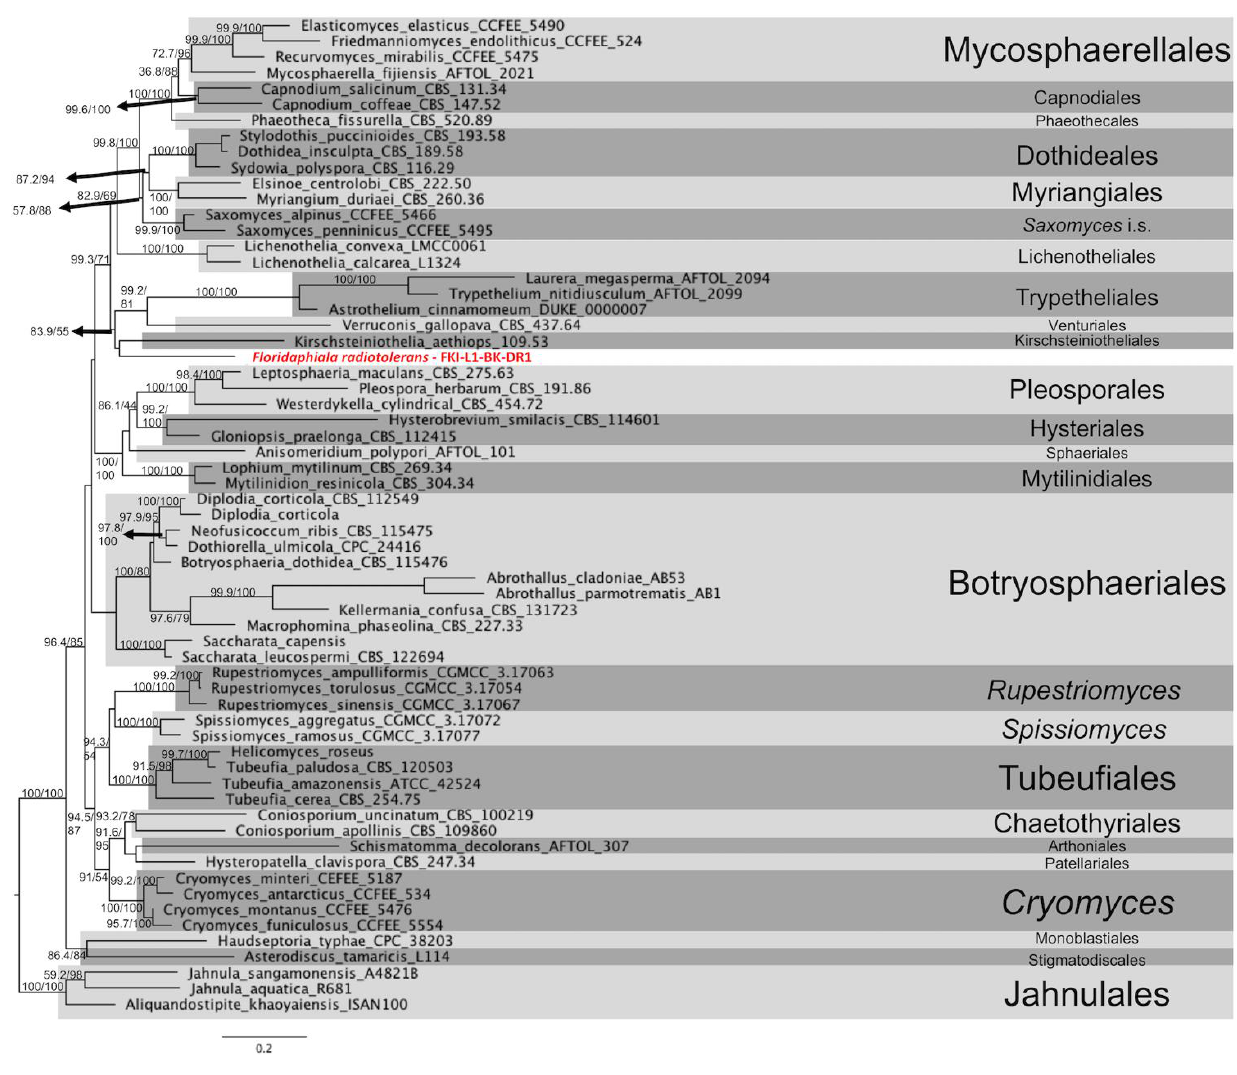
Figure 8. The MLST tree of F. radiotolerans . Genes ITS , LSU , TEF 1, RPB 2, and TUB were used to investigate the phylogenetic placement of the F. radiotolerans via ML tree on the IQTREE2 software. The branches are proportional to the number of mutations and 1,000 ultrafast bootstraps and SH-aLRT was used to test branch support and added to each corresponding branch of the tree. The tree was rooted with members of the order Jahnulales.